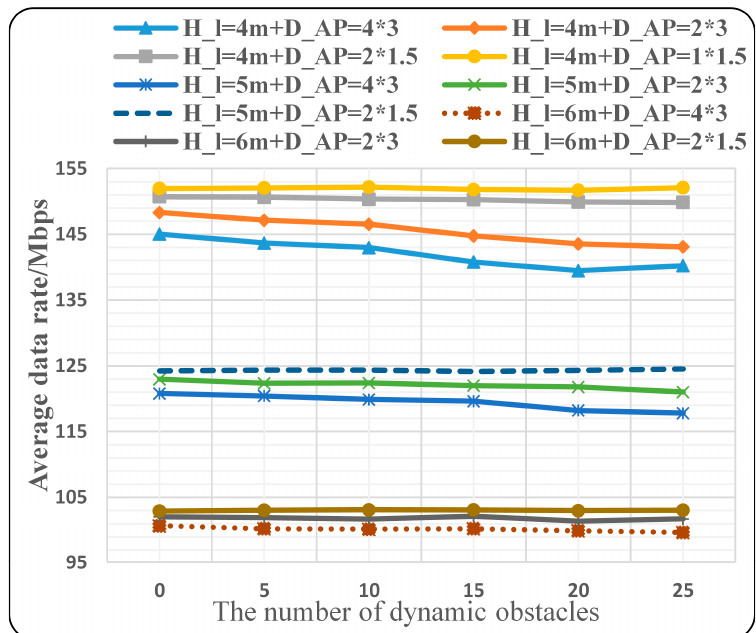
Figure 14. Average data rate under different AP heights and AP